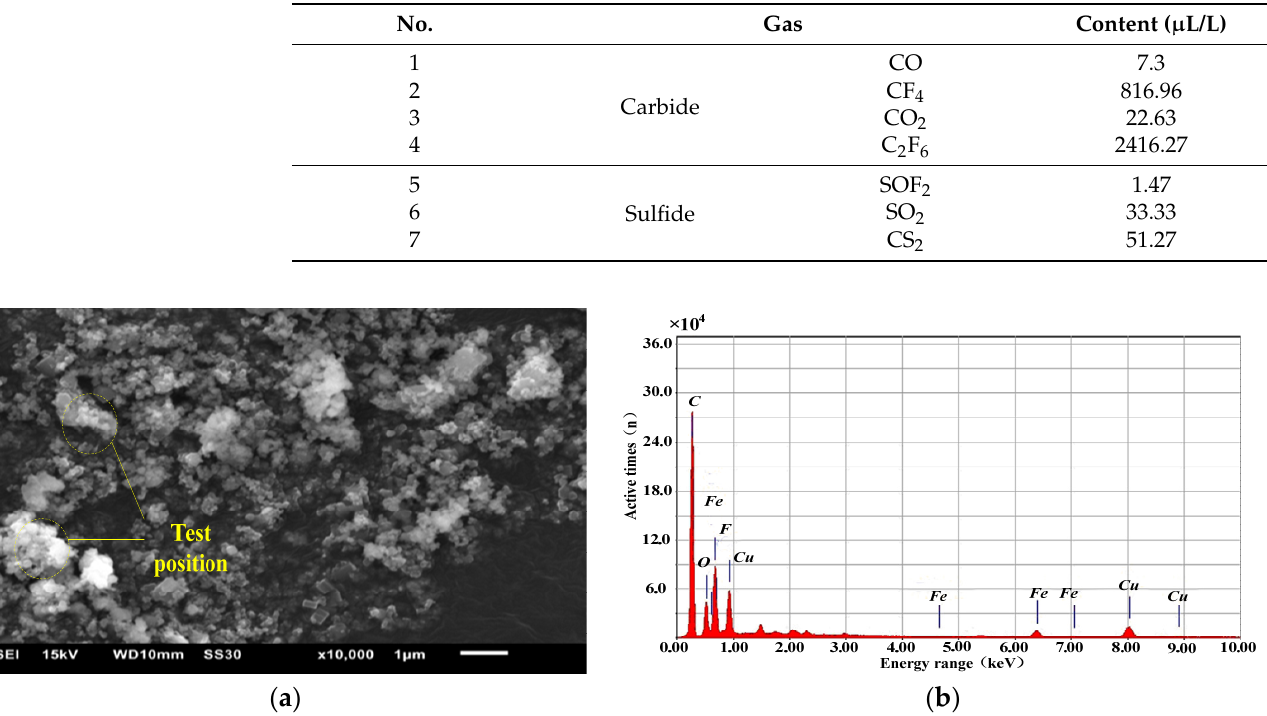
Figure 4. Morphological observation and composition analysis of solid powder in the test circuit breaker. ( a ) Appearance. ( b ) Component.